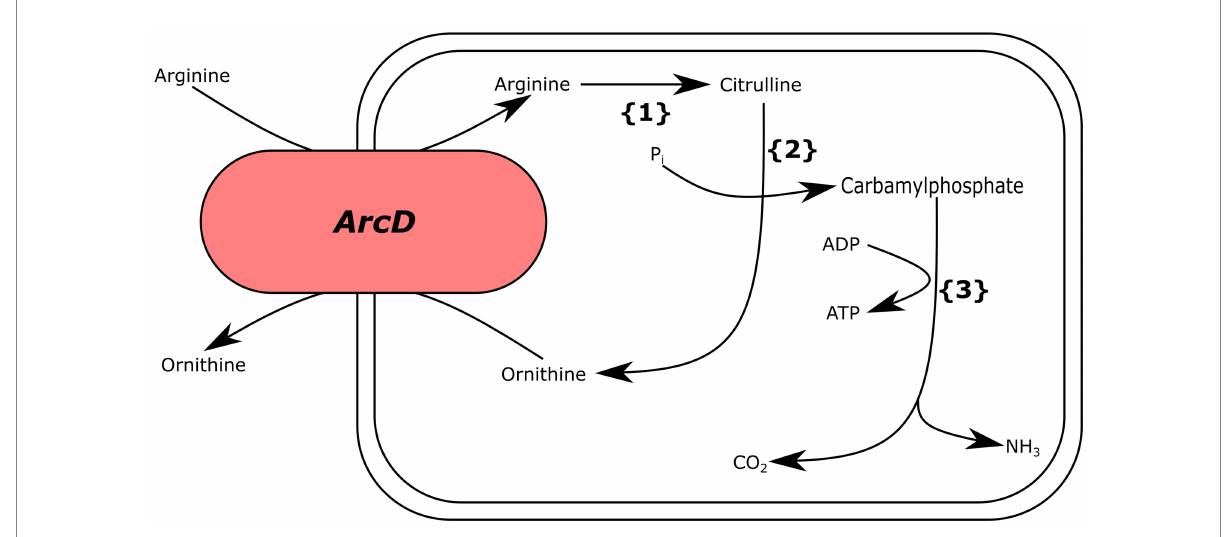
FIGURE 5 Putative arginine deiminase pathway for Ln. pseudomesenteroides 17–2 and TMW21195. {1} arginine deiminase, {2} ornithine transcarbamoylase, {3} carbamate